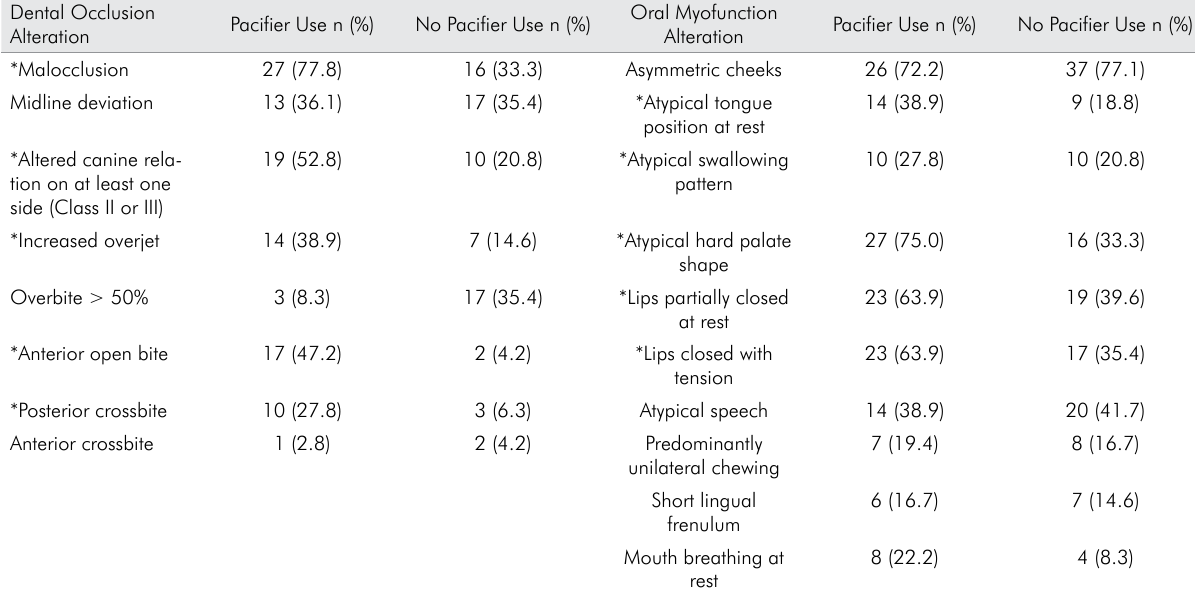
Table 2. Prevalence of dental occlusion and oral myofunction